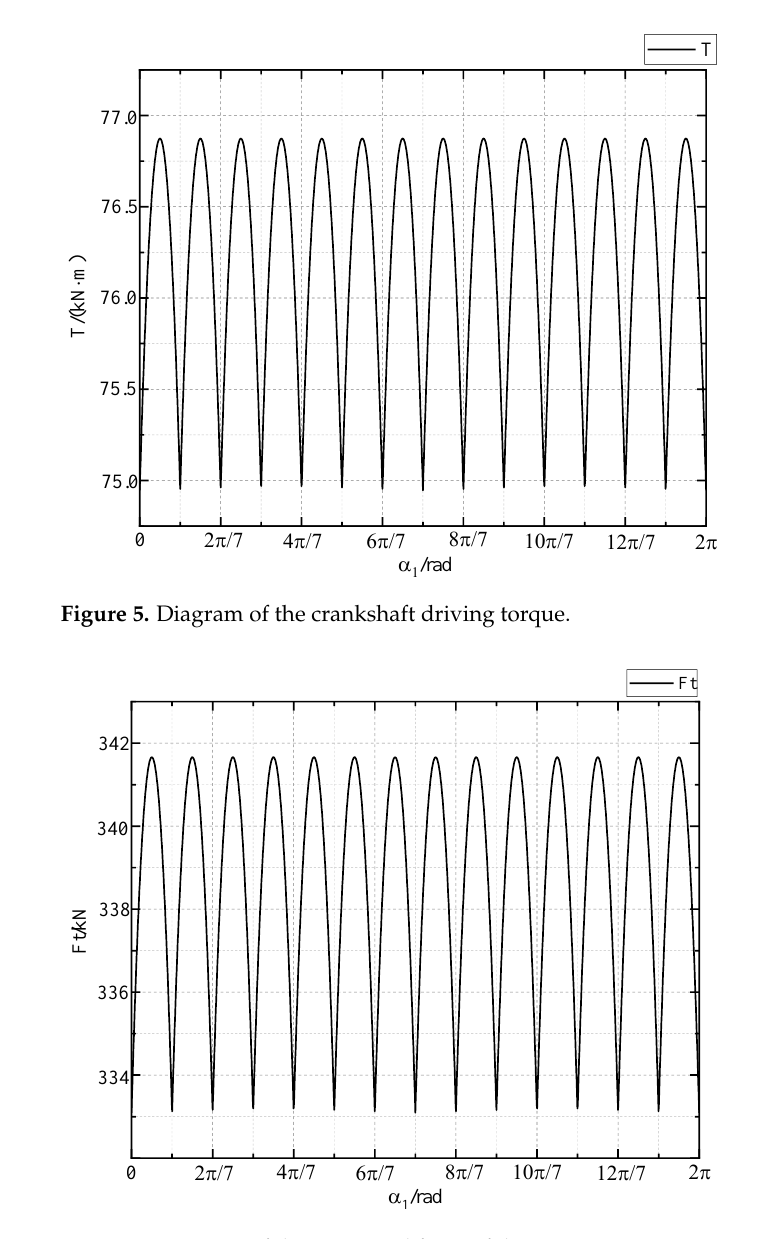
7 of 22 Figure 4. Force analysis of the crankshaft.